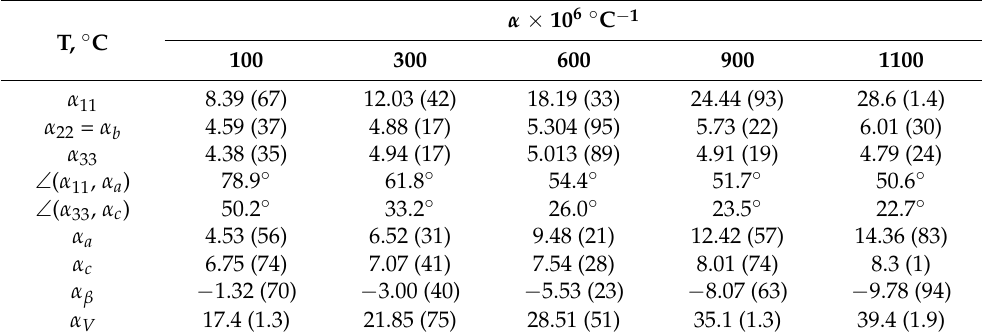
Figure 7. Unit cell parameters of crystallized brannerite in relation to temperature. Table 4. Principal values of the thermal expansion tensor and volumetric expansion of